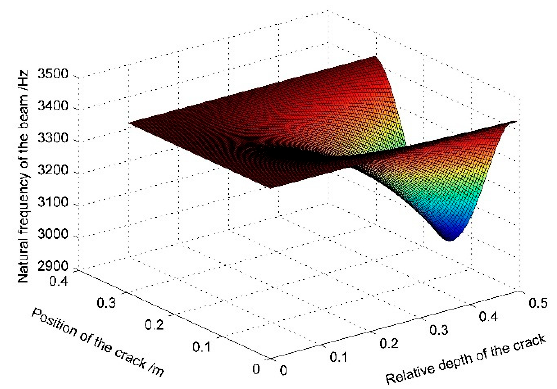
Figure 4. First order natural frequency variation.